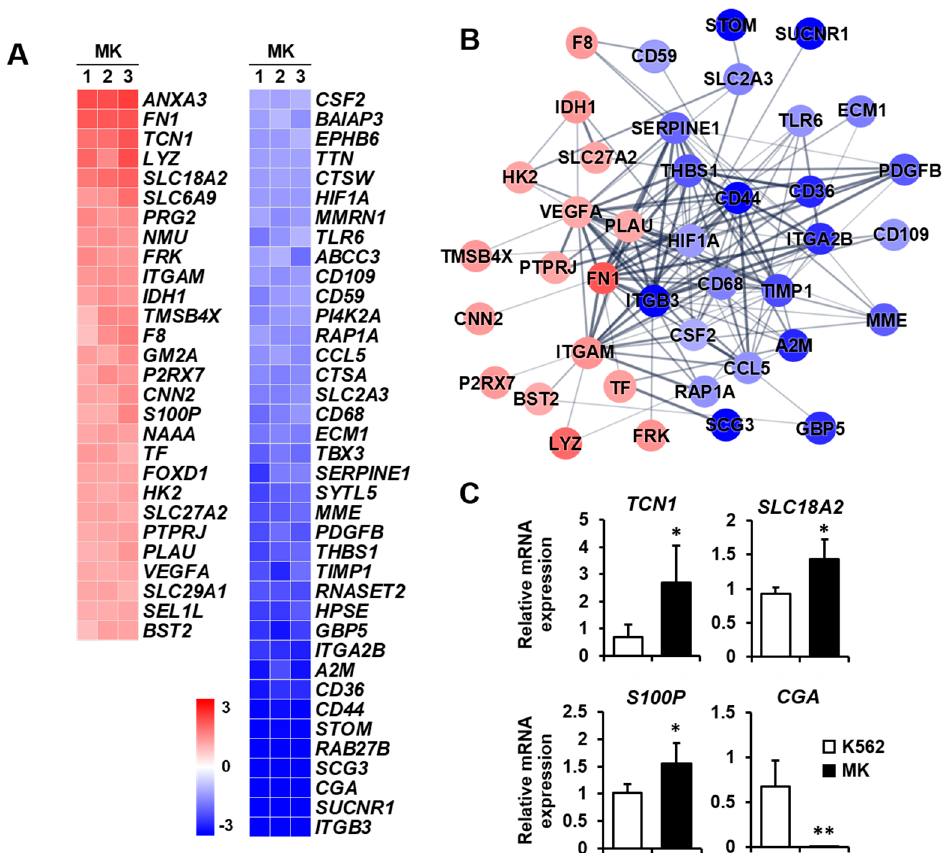
Figure 7. Expression levels by z-scores of genes included in the secretion cluster and the relationship between constituent genes. ( A ) Heat map of genes differentially expressed in megakaryocytes (MKs) compared with K562 cells based on the microarray analysis. The red color indicates upregulation and the blue color indicates downregulation. The degrees of colors represent the expression levels of the genes. ( B ) Protein–protein interaction analysis using the STRING database. The red and blue colors denote upregulation and downregulation, respectively. The higher the confidence in the interaction, the greater the line thickness between the proteins. Members without interaction with other genes were excluded from the STRING database analysis. ( C ) Validation of the mRNA expression of selected genes ( TCN1, SLC18A2, S100P, and CGA ) differentially expressed in MKs by qPCR. Relative expression levels were plotted against gene expression levels in K562 cells. Data are presented as the mean ± standard deviation of three independent experiments. Please see abbreviations for the full names of genes. *, p < 0.05; **, p < 0.01 versus K562 cells.